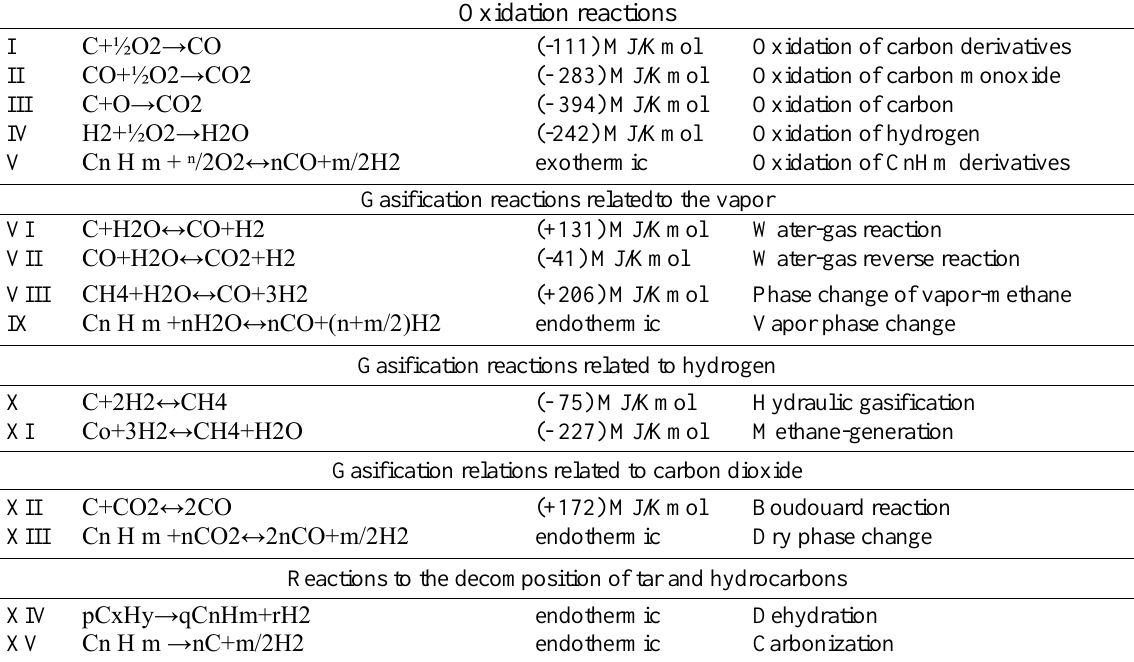
Table 1 . Main reactions of homogeneous and non-homogeneous phases during gasification of municipal waste material, Klein (2002) and Arena